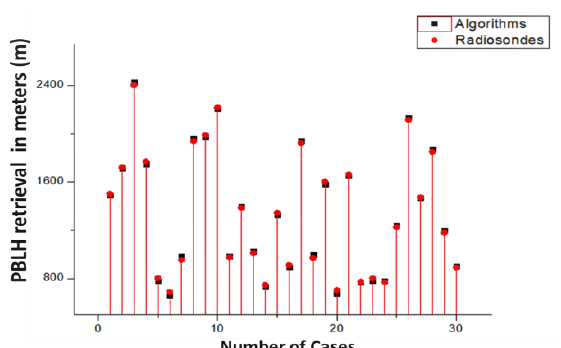
Fig. 3. PBLH retrieval with the single pointing EOLE NTUA lidar after the application of [2, 3] algorithms processing with appropriate settings (black squares), compared with HNMS radiosonde data (red cycles) at the same date and time over Athens, between the years of 2014 to 2016, showing an agreement inside 35m in all these cases.